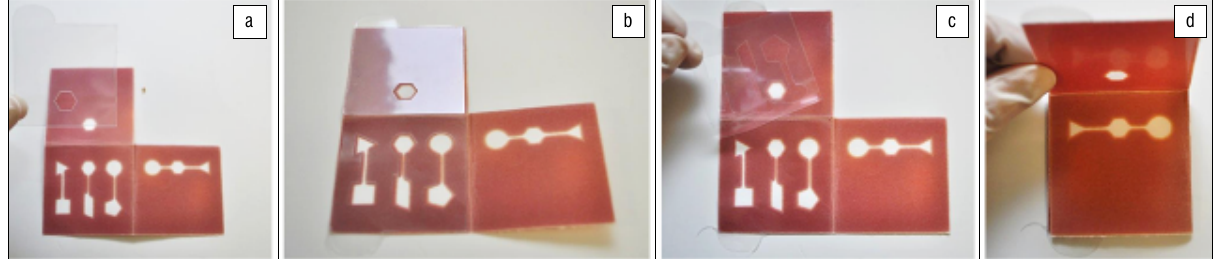
Figure 4: Example of device assembly using adhesive layers: (a, b) the layers are applied to the wax device and (c) the top protective layer is then removed before (d) folding and sealing of the layers of the 3D